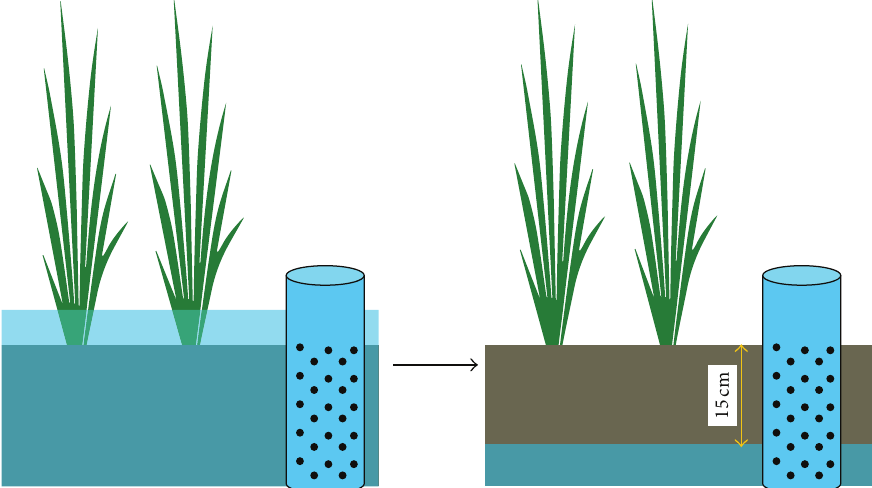
Figure 3: Changes in groundwater level in a paddy field in which wet/dry cycles to strengthen rice [8] are applied to enhance aeration of the soil and elongation of rice